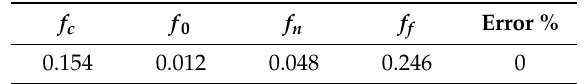
Table 4. The final constants of GTN damage model obtained using the Kriging